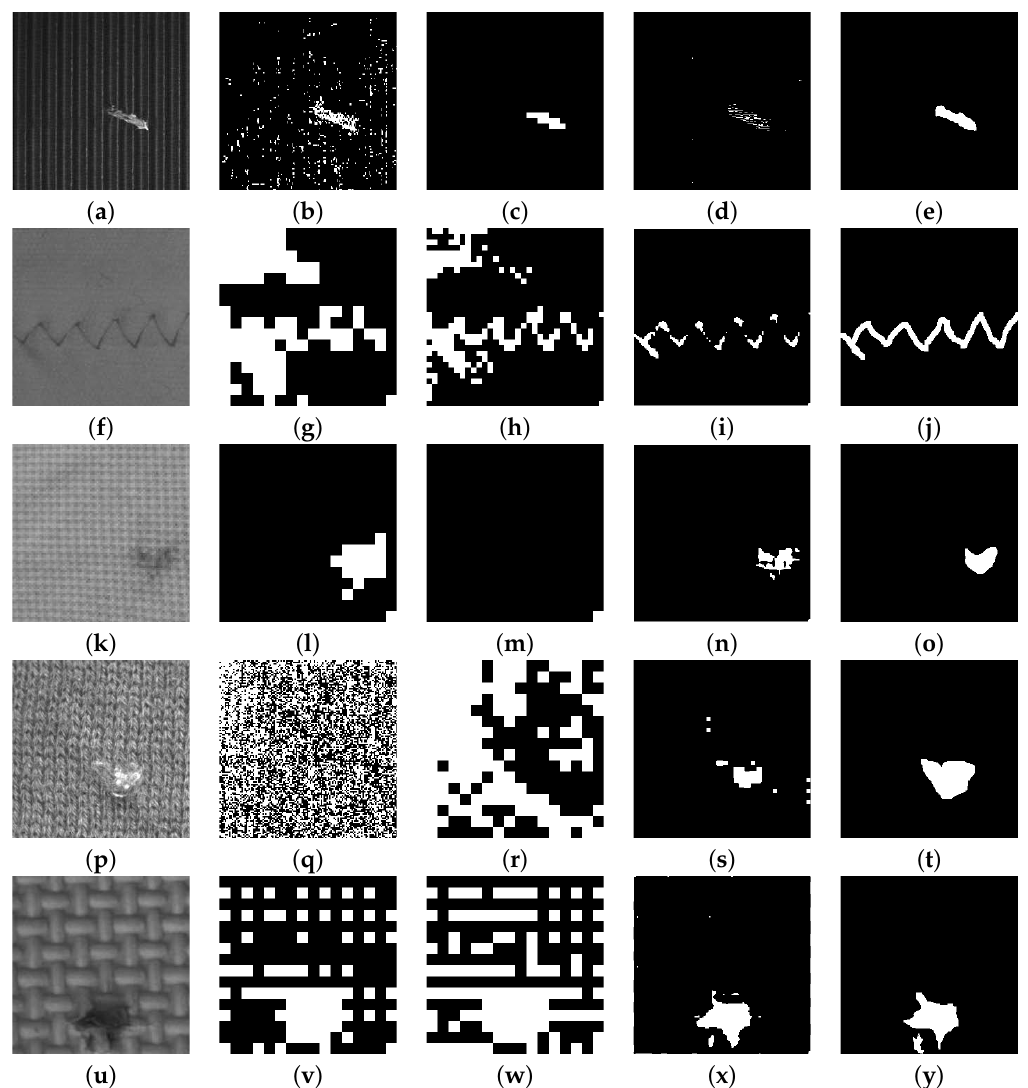
Figure 11. Defects in different structural texture. ( a ) milled surface, ( f ) fabric fine-appearance, ( k ) fabric medium-appearance, ( p ) fabric coarse-appearance and ( u ) bamboo weave; ( b , g , l , q , v ) are the images resulting from the Tsai method; ( c , h , m , r , w ) are the images resulting from the Han method; ( d , i , n , s , x ) are the images resulting from the EADL method; ( e , j , o , t , y ) are the ground-truth images resulting from segmentation carried out by human